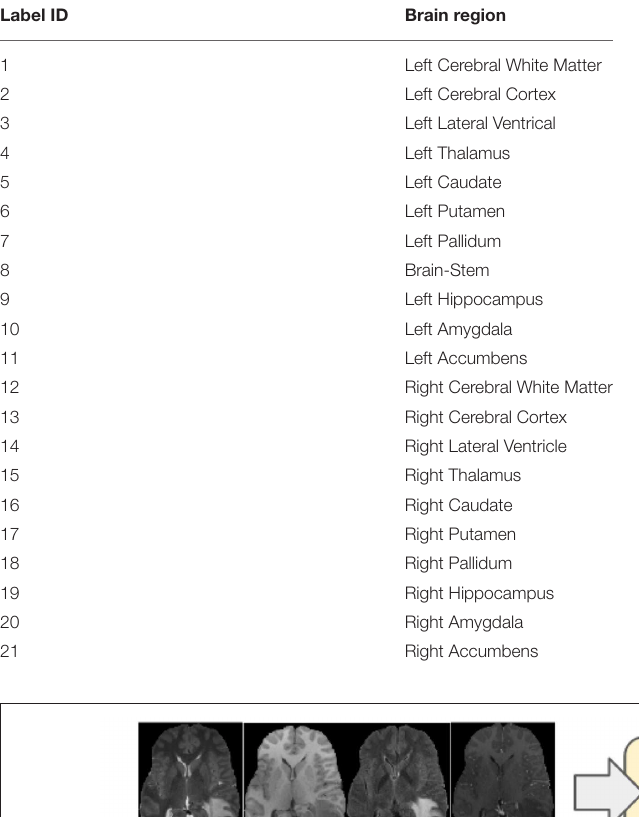
TABLE 1 | The label ID and corresponding brain region of Harvard-Oxford Subcortical Atlas.